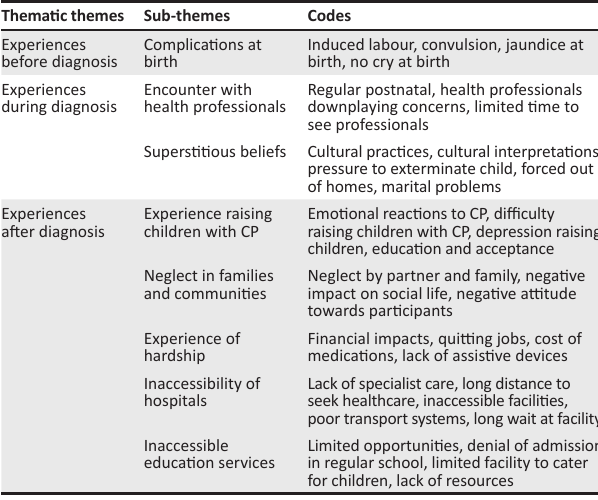
TABLE 2: Summary of thematic